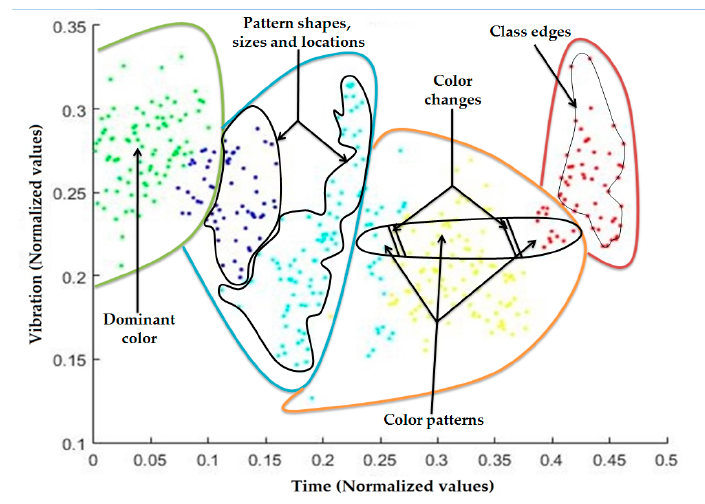
Figure 10. CMO clustering illustrative example.